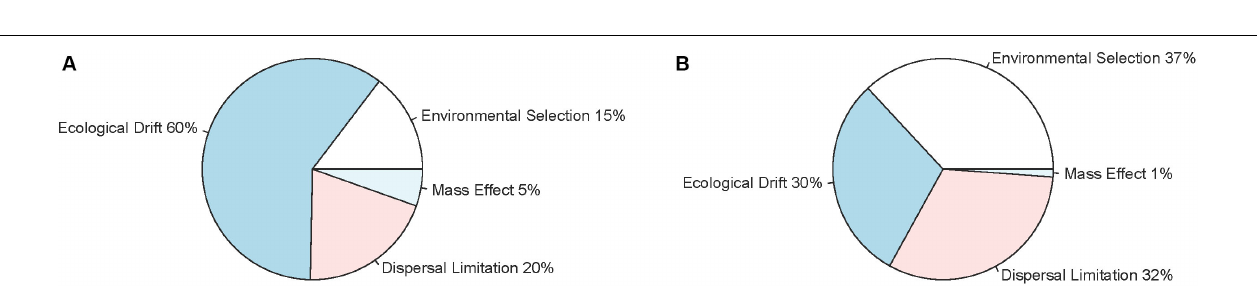
Frontiers in Ecology and Evolution |